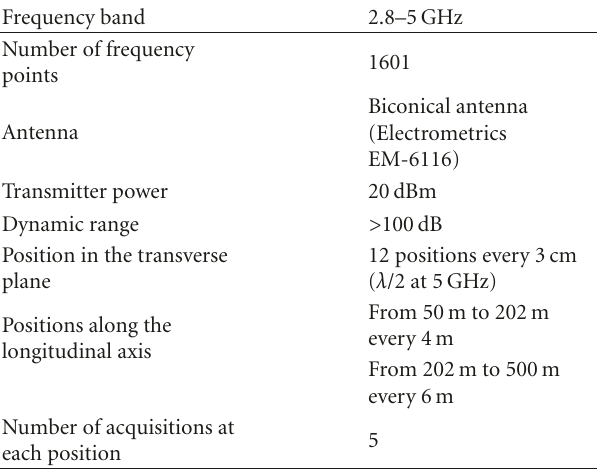
Table 1: Equipment characteristics and measurement